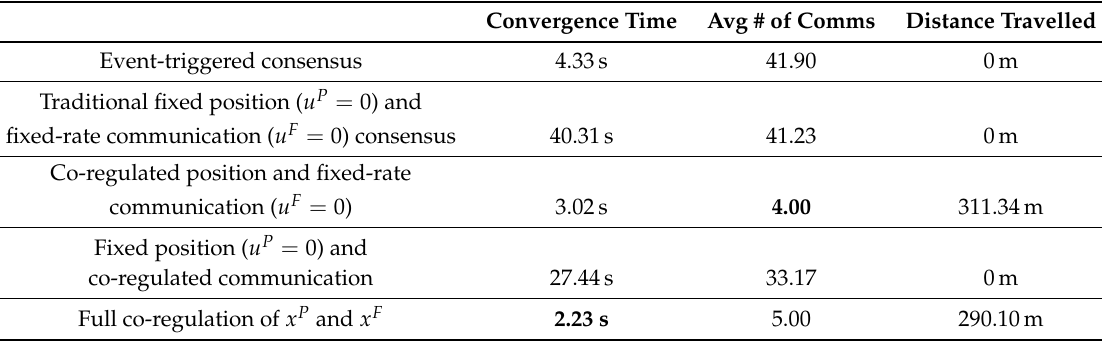
Table 4. Comparison of co-regulation against other strategies.